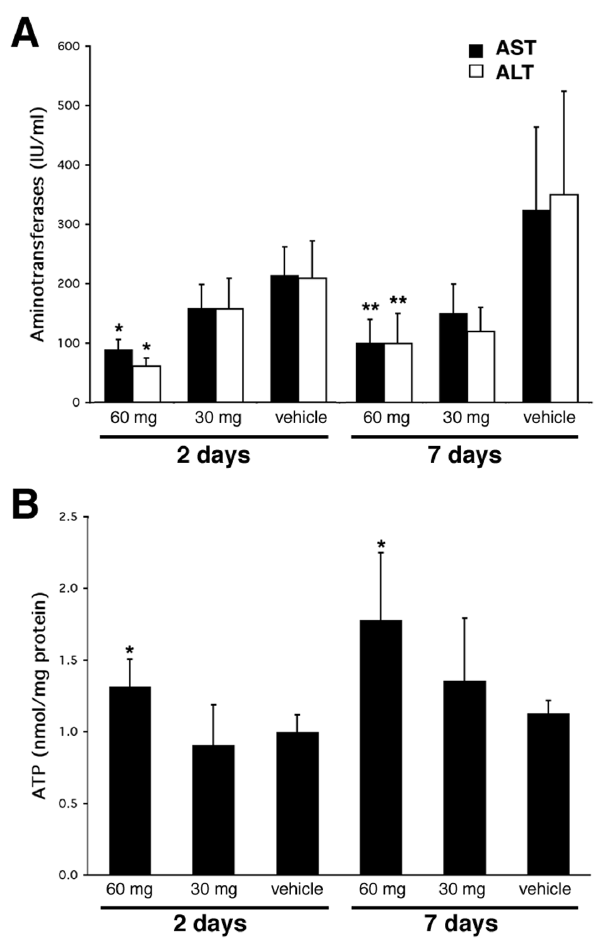
Figure 2. Serum AST/ALT and ATP contents. Panel A , serum AST/ ALT changes with 2 days or 7 days of daily cerulenin treatment. Panel B , ATP content with 2 days or 7 days of daily cerulenin treatment. *: P , 0.05 ; **: P , 0.01 .